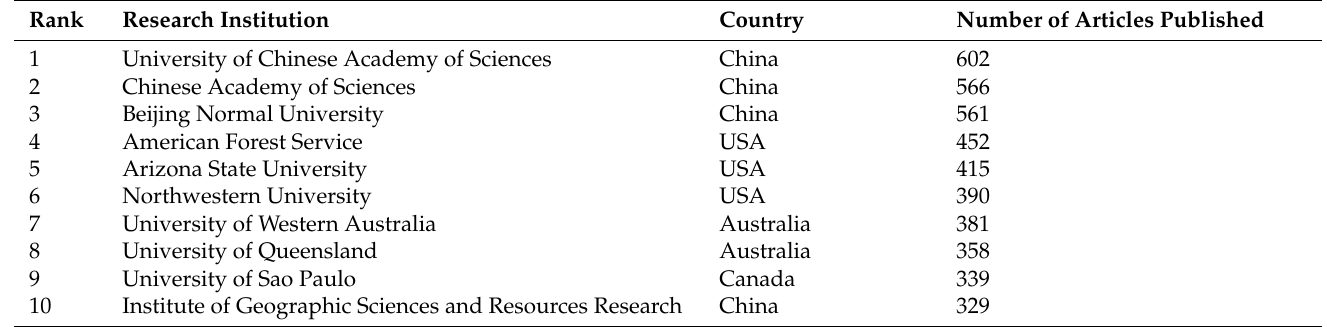
Table 3. Top 10 research institutions in terms of literature volume in the field of ecological